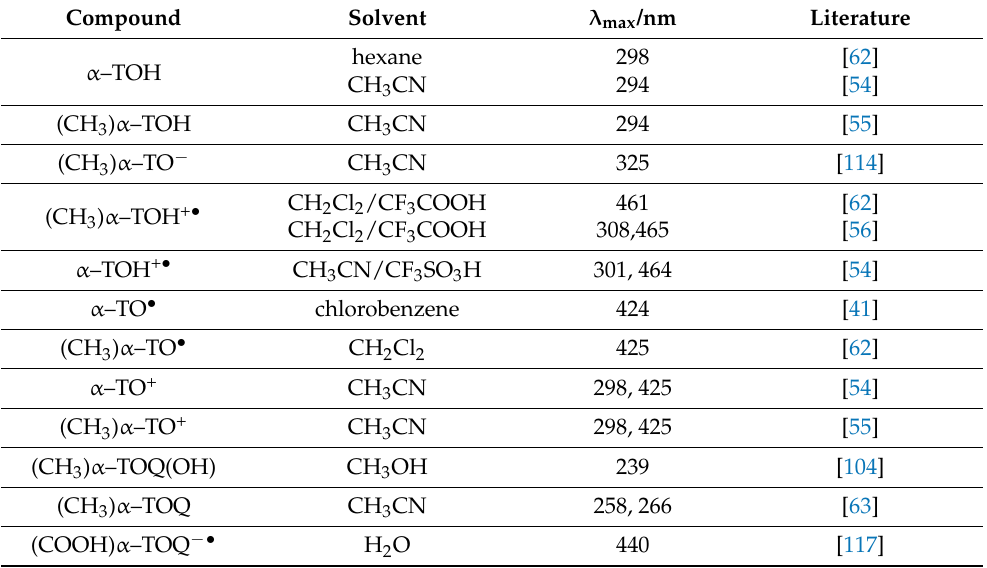
Table 1. Selection of solution phase UV-vis absorption data for vitamin E and its model compounds and their oxidized forms.